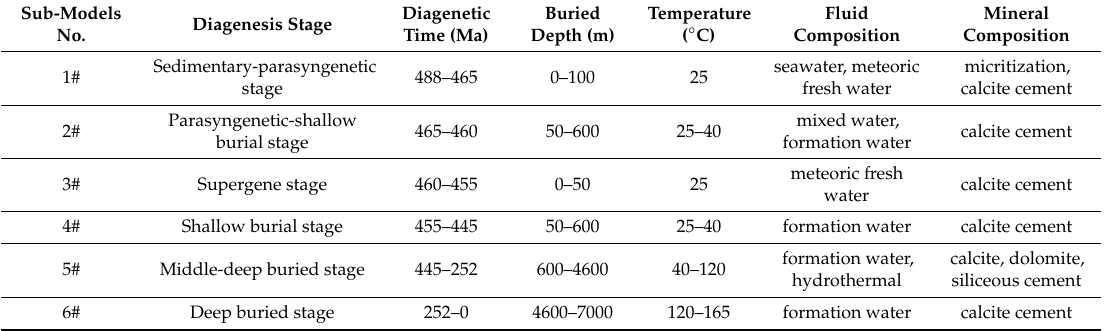
Table 3. Parameters of six sub-models corresponding to di ff erent diagenetic stages. Sub-Models